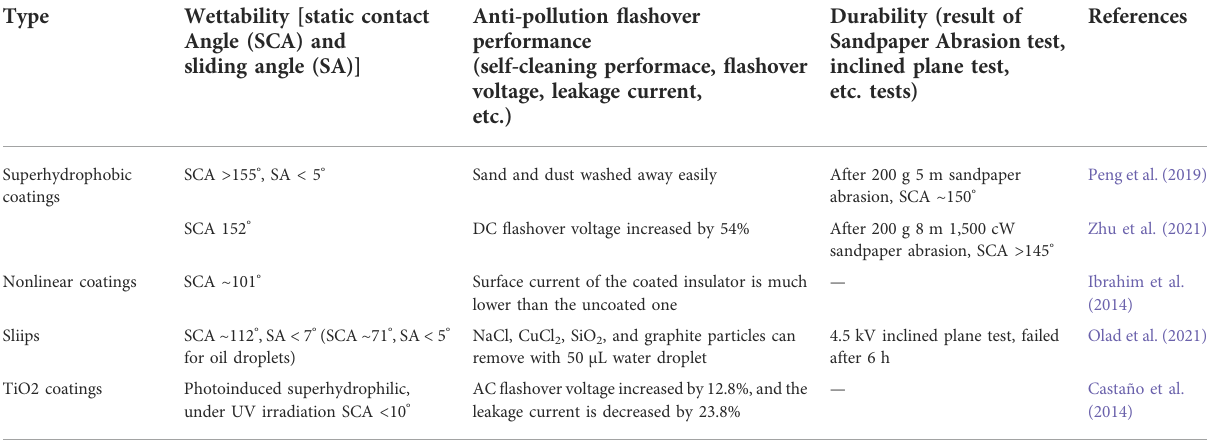
TABLE 3 Performance comparison of typical researches about functional coatings of Insulators